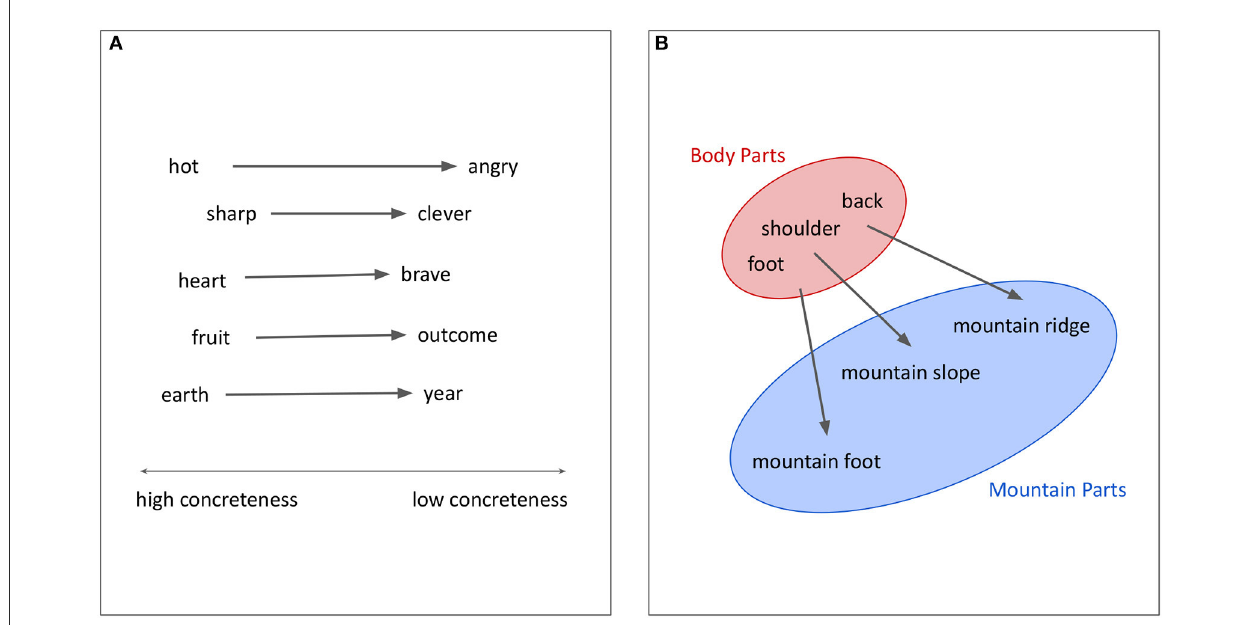
FIGURE1 Illustration of the two aspects of regularity analyzed in semantic change across languages. Meanings or senses of a word are annotated in English words or phrases, and arrows indicate the direction of semantic change from a source meaning toward a target meaning. (A) Regularity in direction. (B) Regularity in source-target